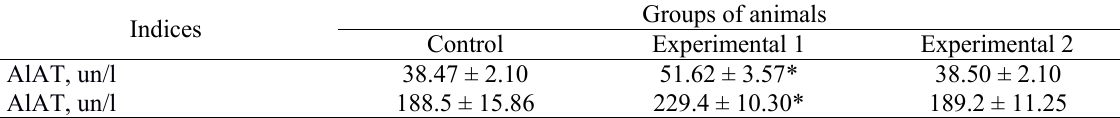
Functional state of rat liver in experimental modeling of heart failure and action of the preparation “Bendamin” (M ± m, n = 6)